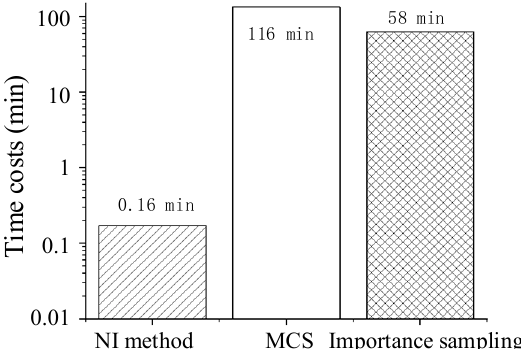
Figure 17. Comparison of the time costs of different methods.